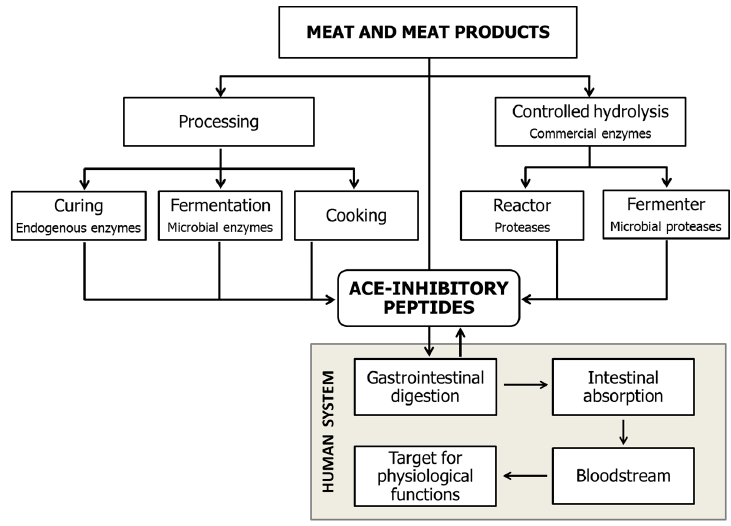
Figure 2. Different ways to generate ACEI-inhibitory peptides.